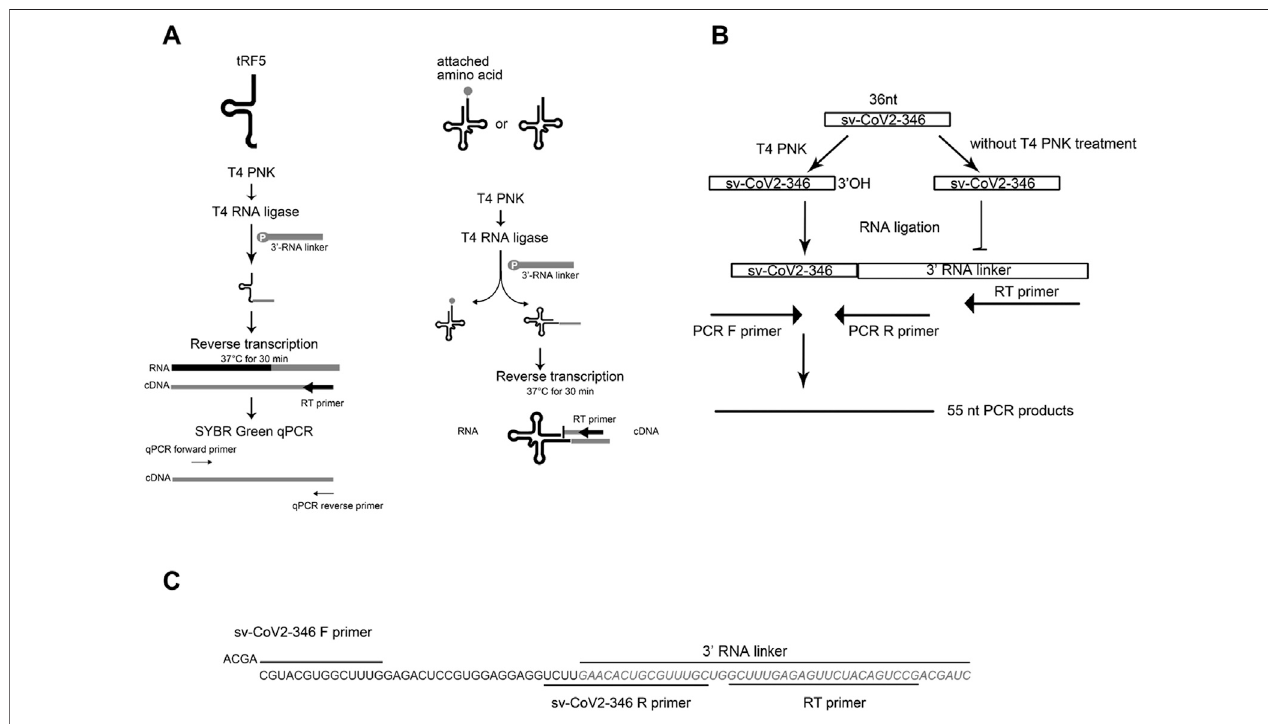
FIGURE 1 | The schematic summaries on tRF quanti fi cation by qRT-PCR (A) and the detection of sv-CoV2-346 by RT-PCR (B) . (C) The sequence information on sv-CoV2-346 and associated primers and the 3 ′ RNA linker for its